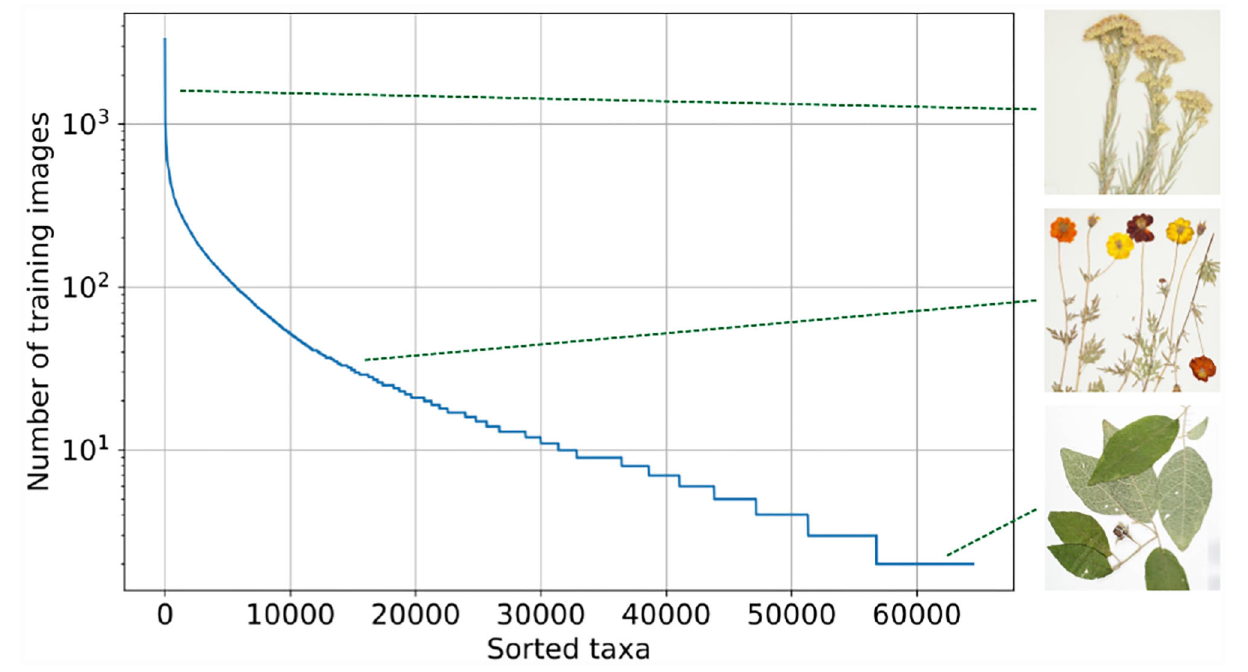
FIGURE 1 | Distribution of training images per taxon. The Herbarium 2021 Half–Earth dataset is highly imbalanced. Featured taxa are from top to bottom: Ericameria nauseosa (Pall. ex Pursh) G.L. Nesom & G.I. Baird (Asteraceae), Bidens sulphurea (Cav.) Sch. Bip. (Asteraceae), and Solanum rixosum A.R. Bean (Solanaceae).